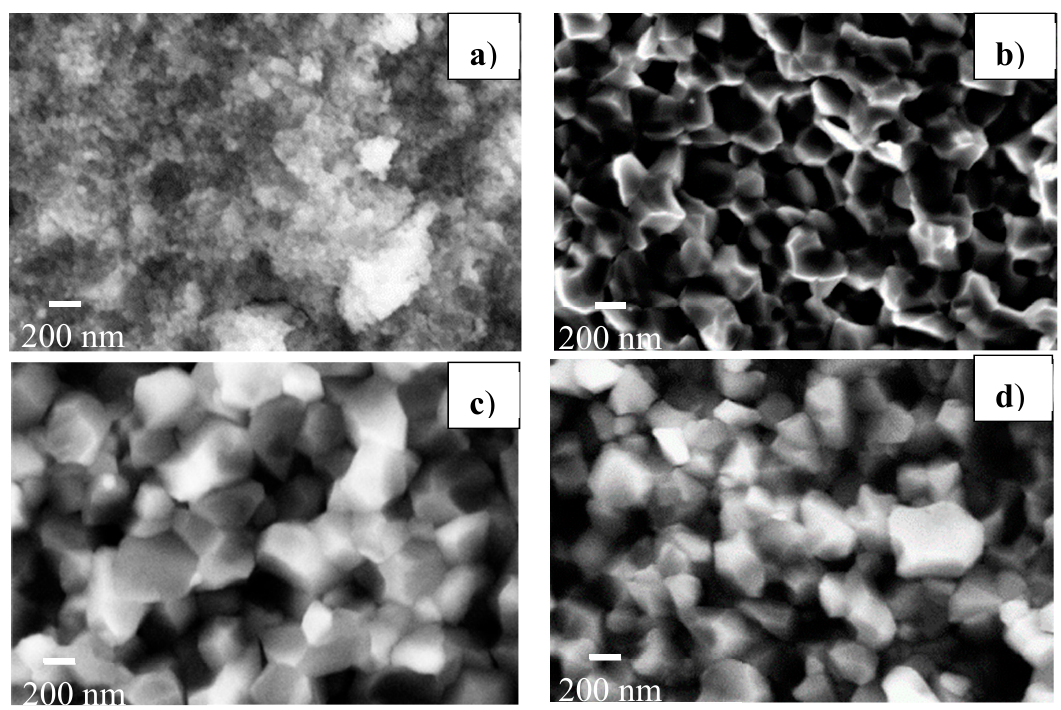
Figure 6. SEM images of the sintered pellets at 700 °C with the different pressures of ( a ) 76, ( b ) 200, ( c ) 300 and ( d ) 400 MPa.